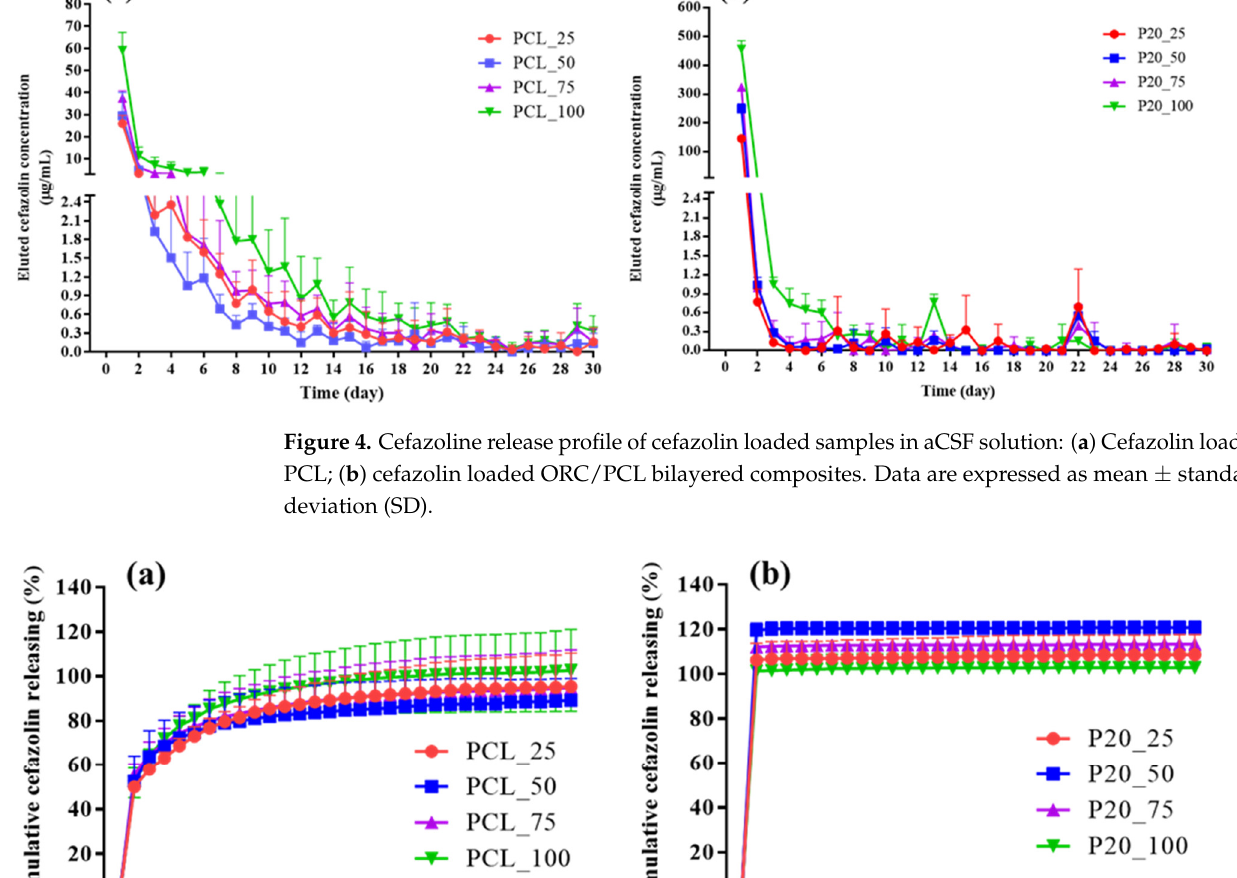
Table 3. Minimum inhibitory concentration (MIC) value of cefazolin against S. aureus ATCC 50923.